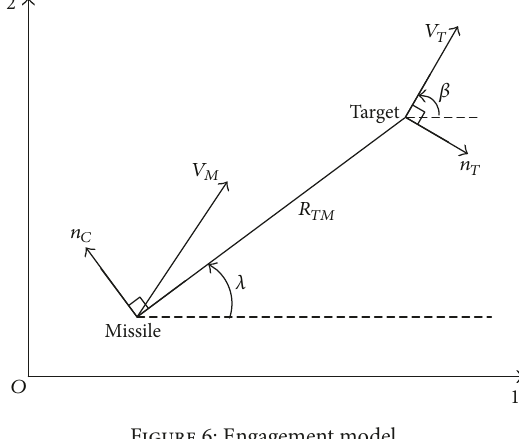
Figure 6: Engagement